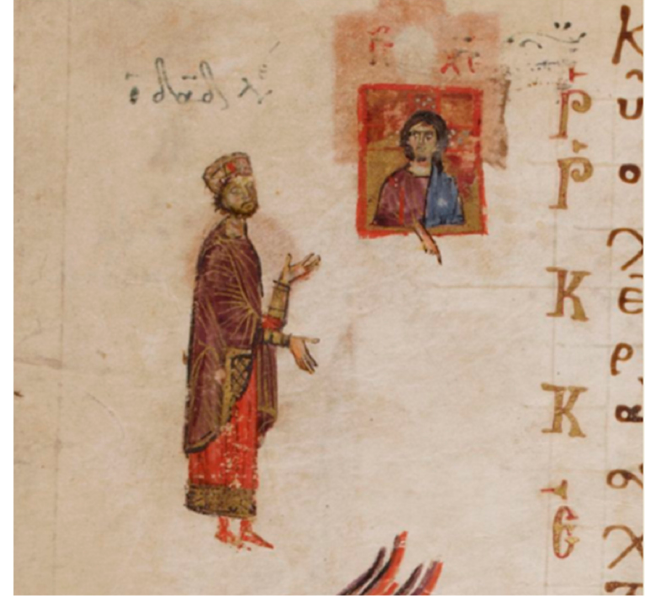
Figure 3. London. British Library. Add MS 19352, fol. 15v (detail). David venerates an icon of